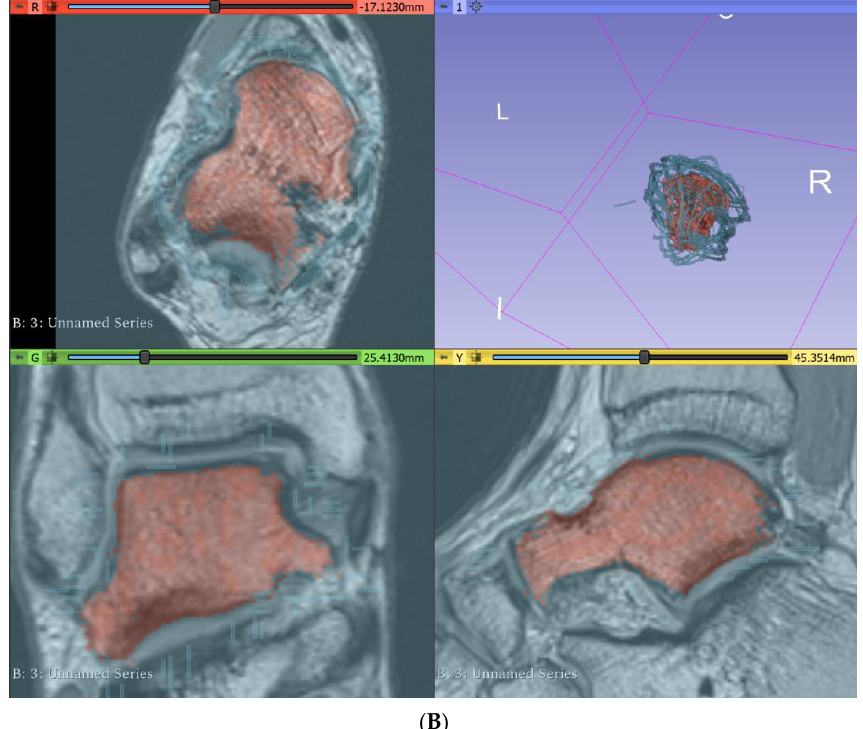
Figure 3. Segmentation of the talus via the “grow with seeds” function in 3D Slicer. ( A ) Seeds planted in the talus (red) and around the talus (blue). ( B ) Resultant segmentation layers. I—inferior, L—left, R—right.